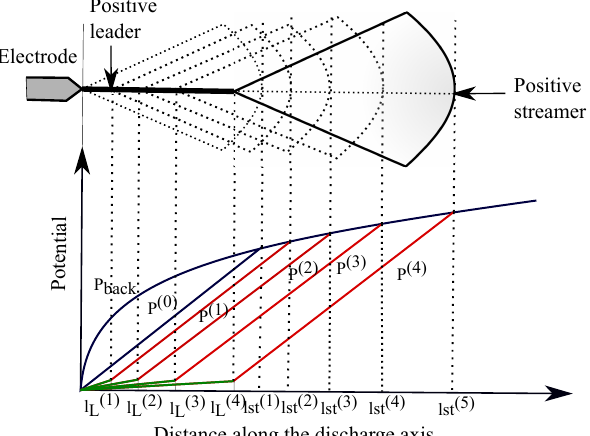
Figure 2. Schematic of positive leader growth and the corresponding axial potential distributions as described in